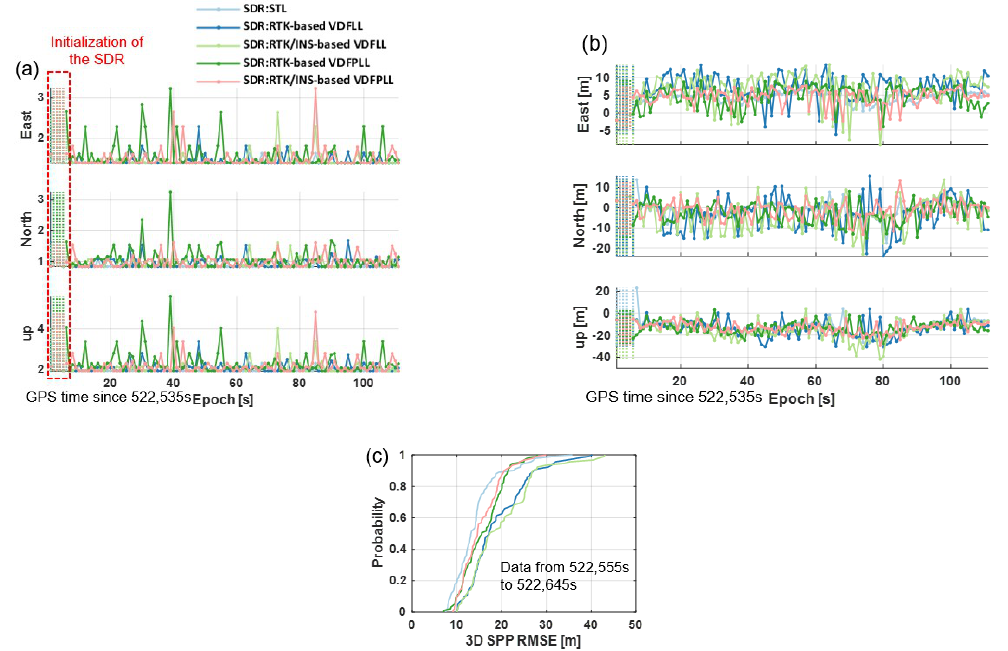
Figure 7. Single point navigation results and statistical analysis of different SDRs in the open-sky situation where dashed lines correspond to outlier epochs. ( a ) DOP values ( b ) SPP results ( c ) CDF curves of 3D SPP RMSE.